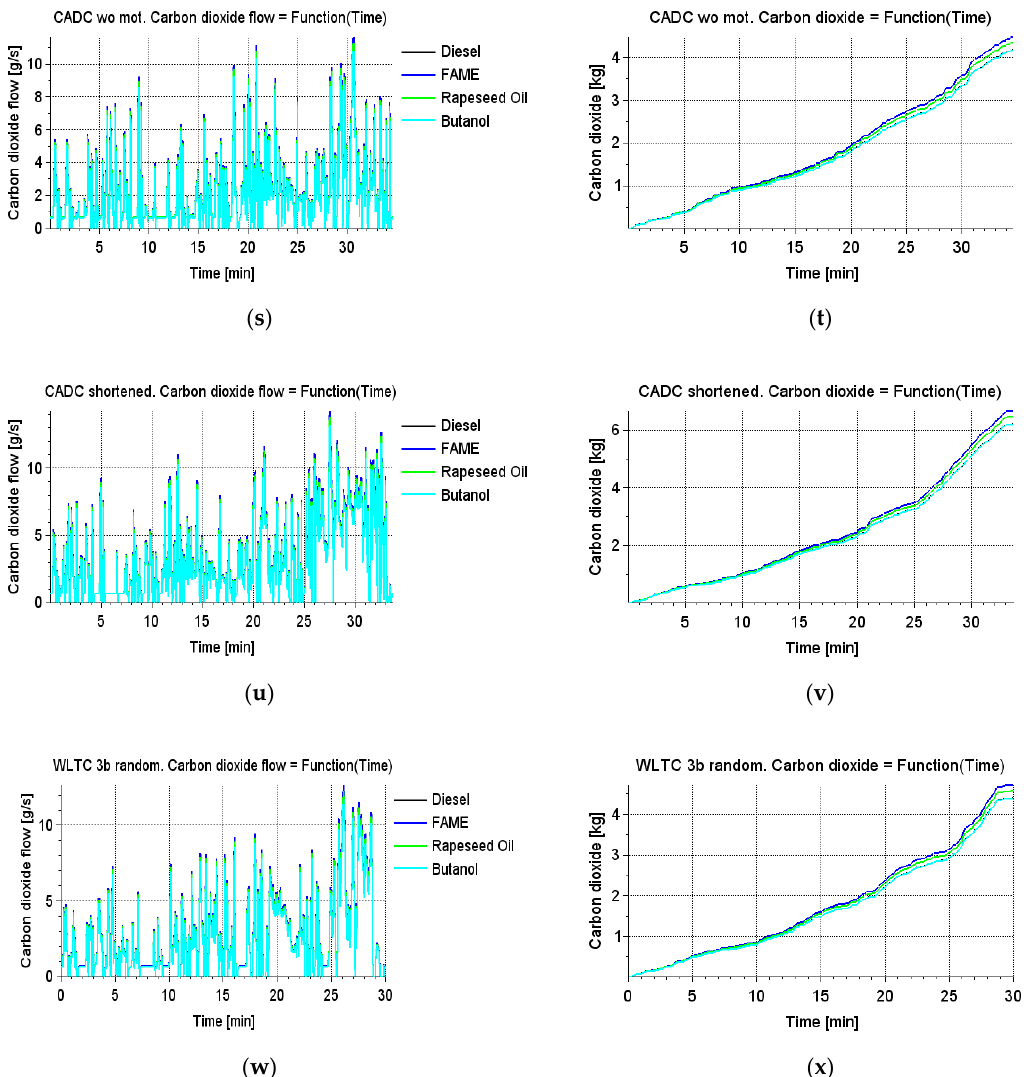
Figure 11. The results of the simulation of the carbon dioxide stream and emission for selected driving tests and fuels for the 2013 Mercedes E350 vehicle: ( a ) Waveforms of the instantaneous values of the carbon dioxide emission stream produced by the vehicle engine, obtained in the simulation of the US 06 road test; ( b ) Waveforms of the instantaneous values of the carbon dioxide emission produced by the vehicle engine, obtained in the simulation of the US 06 road test; ( c ) Waveforms of the instantaneous values of the carbon dioxide emission stream produced by the vehicle engine, obtained in the simulation of the US Highway road test; ( d ) Waveforms of the instantaneous values of the carbon dioxide emission produced by the vehicle engine, obtained in the simulation of the US Highway road test; ( e ) Waveforms of the instantaneous values of the carbon dioxide emission stream produced by the vehicle engine, obtained in the simulation of the FTP 75 road test; ( f ) Waveforms of the instantaneous values of the carbon dioxide emission produced by the vehicle engine, obtained in the simulation of the FTP 75 road test; ( g ) Waveforms of the instantaneous values of the carbon dioxide emission stream produced by the vehicle engine, obtained in the simulation of the NEDC road test; ( h ) Waveforms of the instantaneous values of the carbon dioxide emission produced by the vehicle engine, obtained in the simulation of the US 06 road test; ( i ) Waveforms of the instantaneous values of the carbon dioxide emission stream produced by the vehicle engine, obtained in the simulation of the US SC03 road test; ( j ) Waveforms of the instantaneous values of the carbon dioxide emission produced by the vehicle engine, obtained in the simulation of the US SC03 road test; ( k ) Waveforms of the instantaneous values of the carbon dioxide emission stream produced by the vehicle engine, obtained in the simulation of the Random Cycle Low road test (x05); ( l ) Waveforms of the instantaneous values of the carbon dioxide emission produced by the vehicle engine, obtained in the simulation of the Random Cycle Low road test (x05); ( m ) Waveforms of the instantaneous values of the carbon